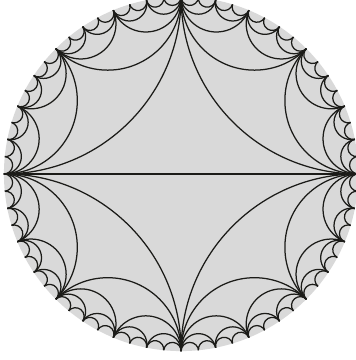
Figure 6 . The dyadic